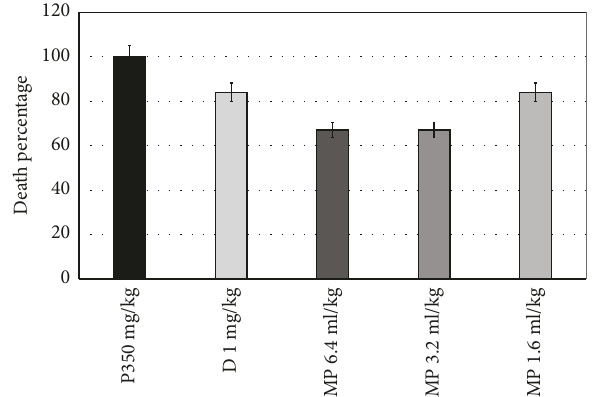
Figure 4: Effects of MPO (6.4,3.2, and 1.6ml/kg) on death per- centage in pilocarpine epilepsy model in mice, ∗ P < 0 . 5 when contrasted to the P350 group, ∗∗ P < 0 . 5 when contrasted to the D group. P: pilocarpine, D: diazepam, MPO: Mentha piperita L . oil.